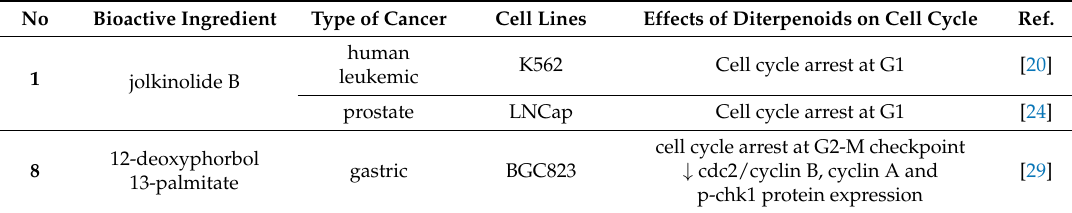
Table 5. Effects of diterpenoids on cell